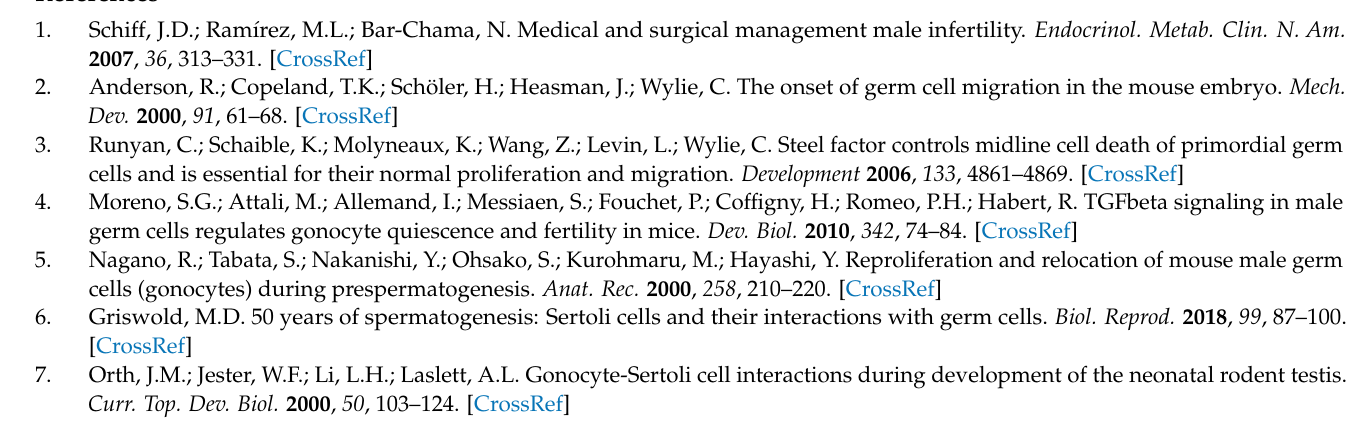
desynchronized. Figure S5. Histology of 12 month-old CTRL and Cul4bAmh;Vasa KO caudal